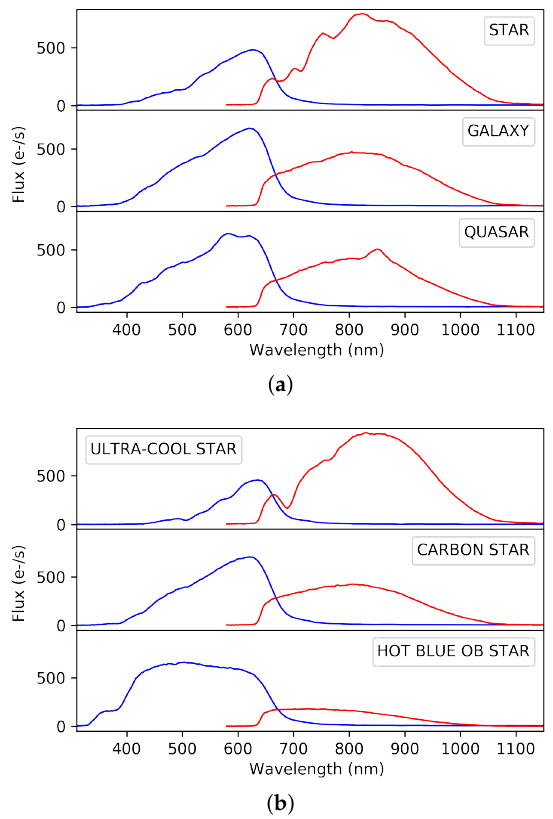
Figure 1. Examples of simulated Gaia spectrophotometric data: Blue Photometer (BP) and Red Photometer (RP). ( a ) simulated Gaia BP/RP data for different object types; ( b ) simulated Gaia BP/RP data for different star